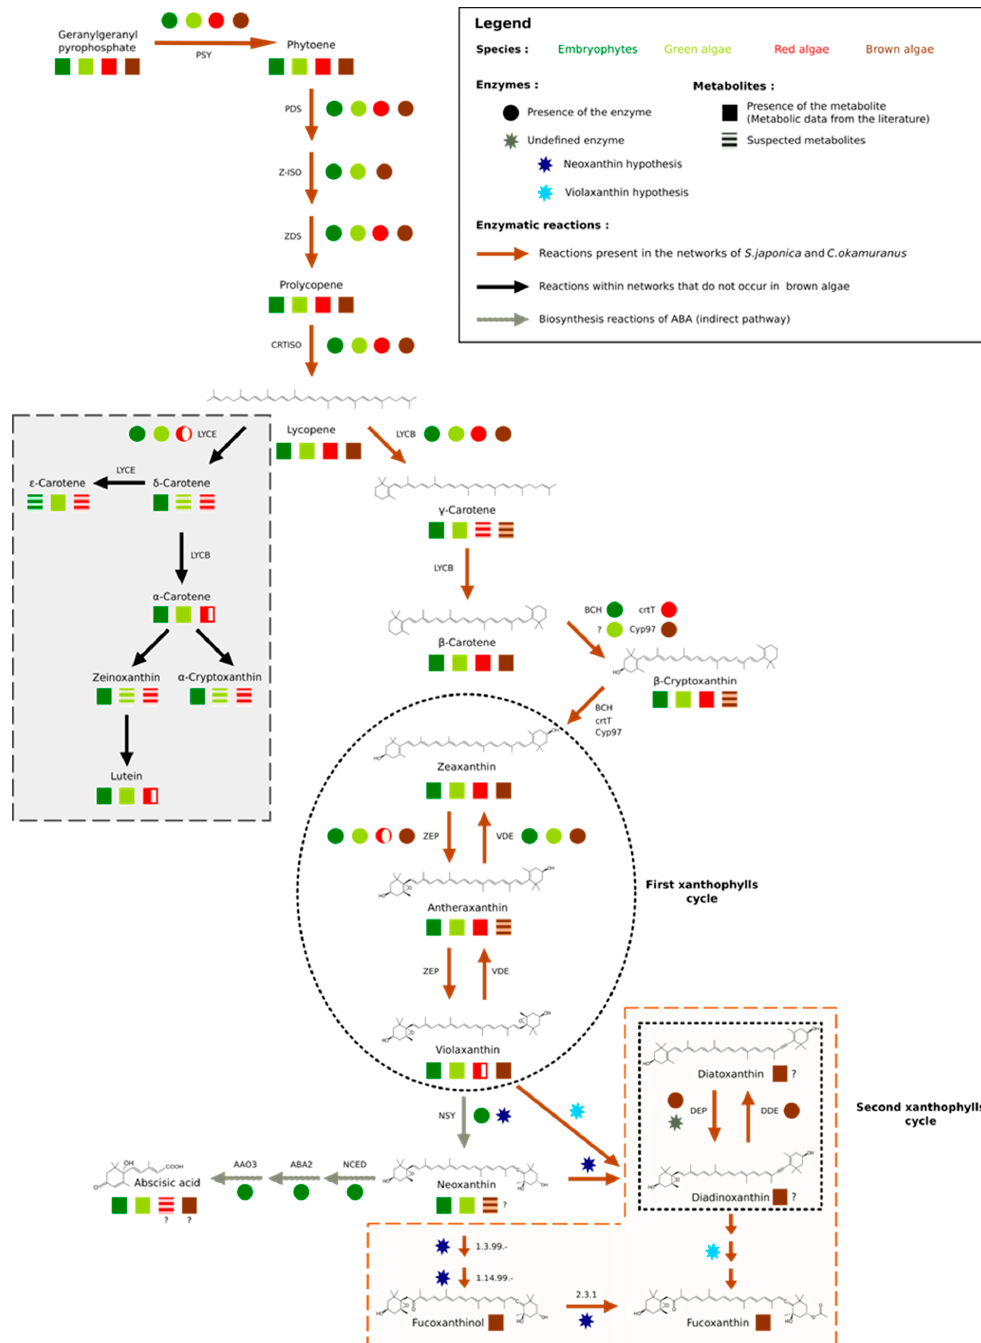
Figure 3 . Carotenoid biosynthesis. The mechanisms of carotenoid synthesis seem to be common to all algae and terrestrial plants. The first connection point is made from lycopene. The synthesis of δ – carotene and its derivatives is absent in red microalgae and brown algae (grey insert), while the synthesis of β – carotene is also common to all organisms. The second point of divergence appears during the first xanthophyll cycle (black circle) partially found in red algae. In terrestrial plants, violaxanthin is transformed into neoxanthin, the starting point for the synthesis of abscisic acid (ABA), among other metabolites. Nevertheless, if this step exists in various algal groups, it seems to be carried out by di ff erent enzymes. Finally, stramenopiles have a second xanthophyll cycle (black square), for which one of the supposed precursors is also neoxanthin and whose enzymes remain to be determined (brown insert). Since pathways have been hypothesized for diatoms, we extended this hypothesis to brown algae. The figure is based on our results and the following references